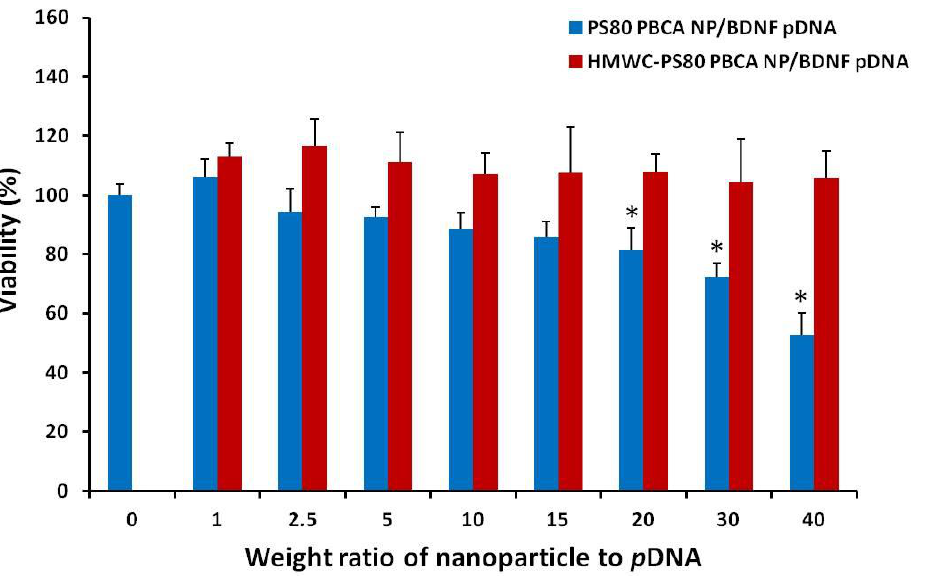
Figure 8. The cytotoxicity of mouse iPSCs to the polyplexes at different weight ratios. The HMWC- PS80 PBCA NP/BDNF p DNA polyplex remained non-toxic throughout the range of dose tested. By contrast, the viability of cells fell below 90% at a weight ratio of 10 for the PS80 PBCA NP/BDNF p DNA polyplex. n = 4; * p < 0.05.